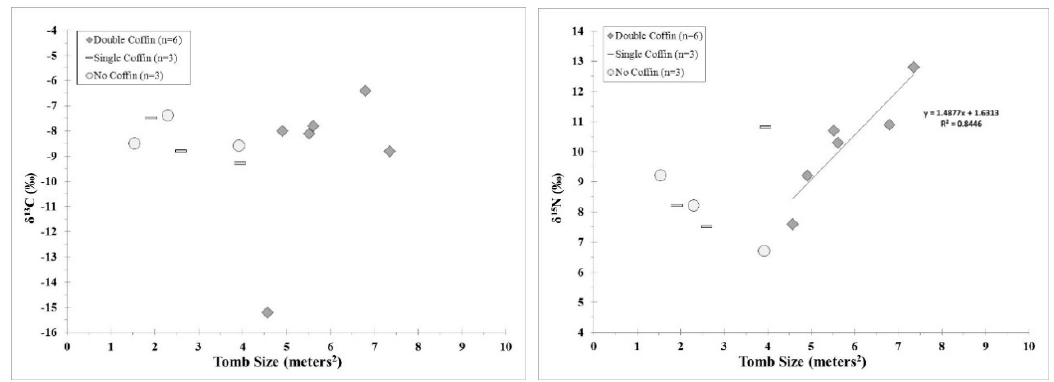
Figure 6. ( a ) δ 13 C results vs. tomb size (m 2 ) for individuals buried in a double, single, or without a coffin at the Xiaohucun site, Henan Province, China; ( b ) δ 15 N results vs. tomb size (m 2 ) for individuals buried in a double, single, or without a coffin at the Xiaohucun site, Henan Province, China.